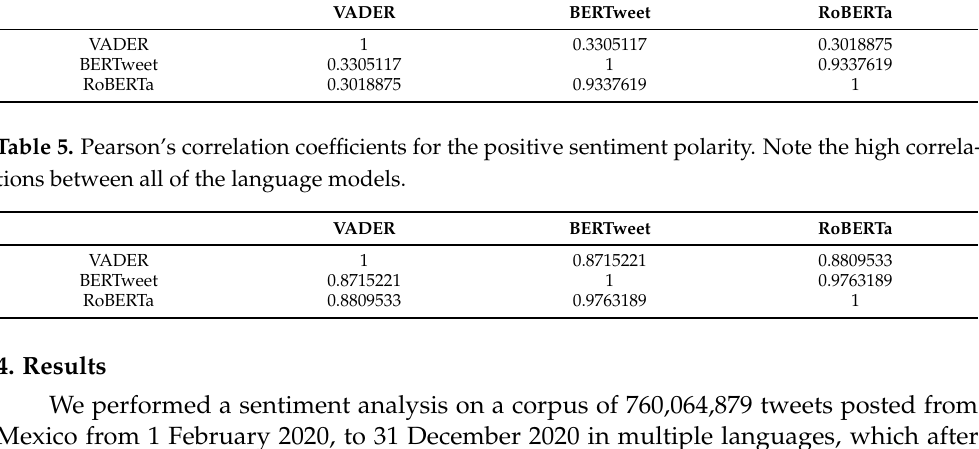
Table 4. Pearson’s correlation coefficients for the compound sentiment polarity. Note the low correlation coefficient when comparing both BERTweet and RoBERTa language models with VADER. VADER BERTweet RoBERTa VADER 1